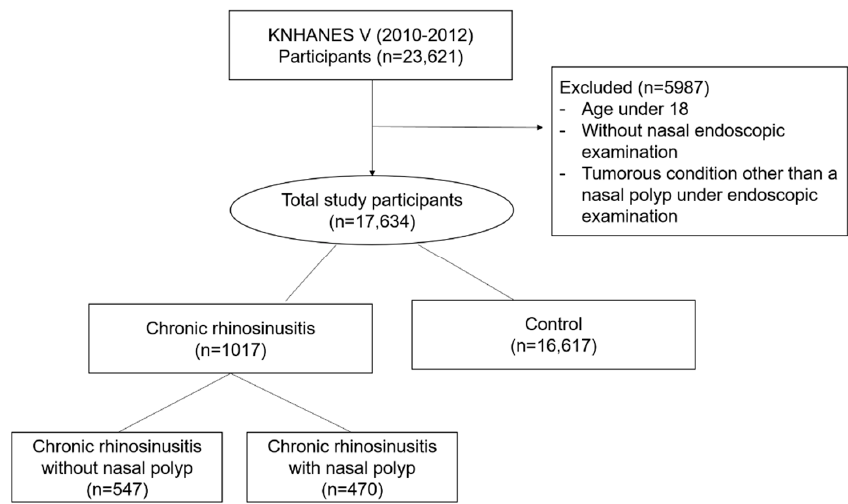
Figure 1. Flow chart of the study population selection. Abbreviation: KNHANES, Korea National and Nutritional Examination Survey; CRS, chronic rhinosinusitis; CRSsNP, chronic rhinosinusitis without nasal polyps; CRSwNP, chronic rhinosinusitis with nasal polyps.